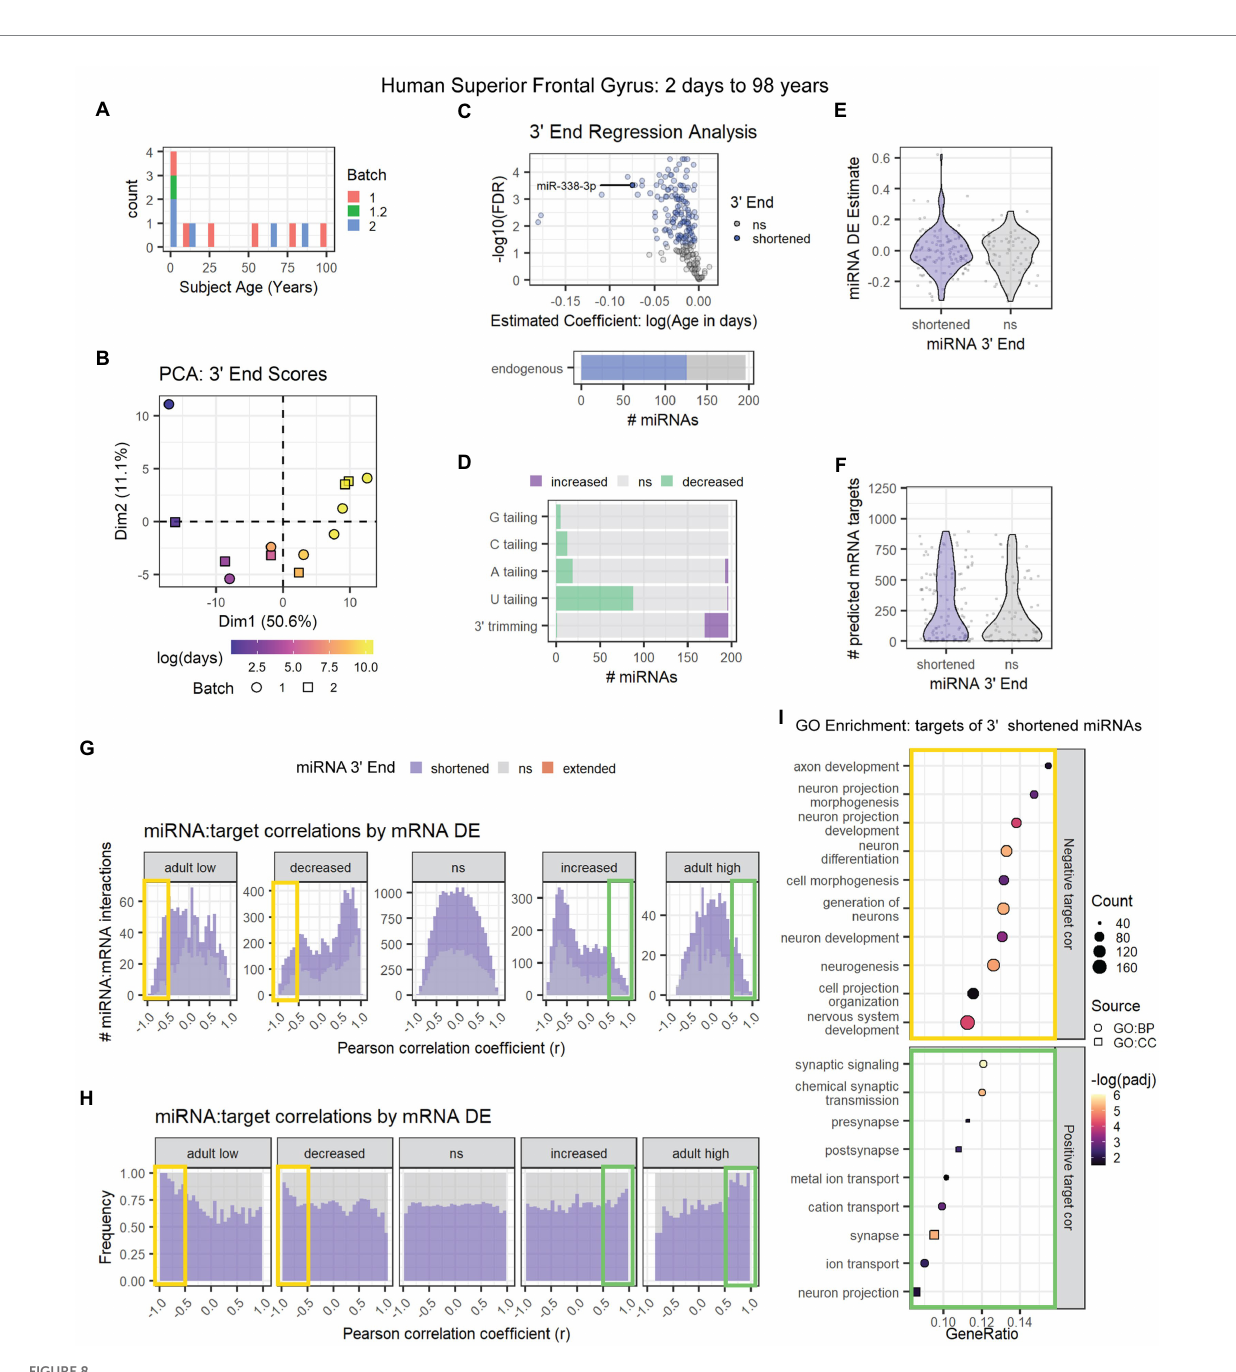
FIGURE 8 Age-associated 3 ′ shortening of miRNAs occurs in human superior frontal gyrus between 2 days and 98 years of age. (A) Age distribution for human subjects used for analyses in A-I. After outlier removal, 12 subjects were included. (B) Samples approximately align by subject age in a PCA plot of 3 ′ end scores. Sample GSM450608 was removed as an outlier based on PCA results (not shown). (C) 3 ′ ERA for human cortex. 126 of 196 miRNAs underwent 3 ′ shortening with age. (D) 3 ′ ERA by modification type revealed that 3 ′ shortening was primarily due to increased 3 ′ trimming and decreased U tailing with age. (E) Violin plot representing the relationship between miRNA 3 ′ end dynamics and the miRNA’s DE Estimate, which summarizes the change in miRNA levels with age. Positive DE Estimate values reflect miRNAs that increase with age, while negative values reflect miRNAs that decrease with age. Each point represents one miRNA. Wilcox test: p = 0.8. (F) Violin plot representing the relationship between miRNA 3 ′ end dynamics and the number of predicted mRNA targets detected for each miRNA. Each point represents one miRNA. Wilcox test: p = 0.17. (G) Pearson correlation analysis was performed for miRNAs and their predicted mRNA targets. Data are organized in histograms by mRNA DE results (See Supplementary Figure S10D for corresponding cluster expression patterns). Y -axis reflects the number of predicted miRNA:target interaction pairs at each Pearson correlation coefficient, r, value. Bar color reflects each miRNA’s 3 ′ end dynamics with age. (H) Pearson correlation analysis organized by mRNA DE results. Y -axis indicates the relative frequency of targeting by miRNAs that have shortened or stable (ns) 3 ′ ends with age. No miRNAs exhibited 3 ′ extension with age. Bar color reflects miRNA 3 ′ end dynamics with age. (I) GO term enrichment analysis results for mRNA targets that decreased with age and exhibited negative correlations ( r < − 0.5, orange box in G,H ) or increased with age and exhibited positive correlations ( r > 0.5, green box in G,H ) with miRNAs that underwent 3 ′ shortening. See Supplementary Figure S10 for PCA results and cluster expression patterns for miRNA-seq and mRNA microarray expression data used in the targeting